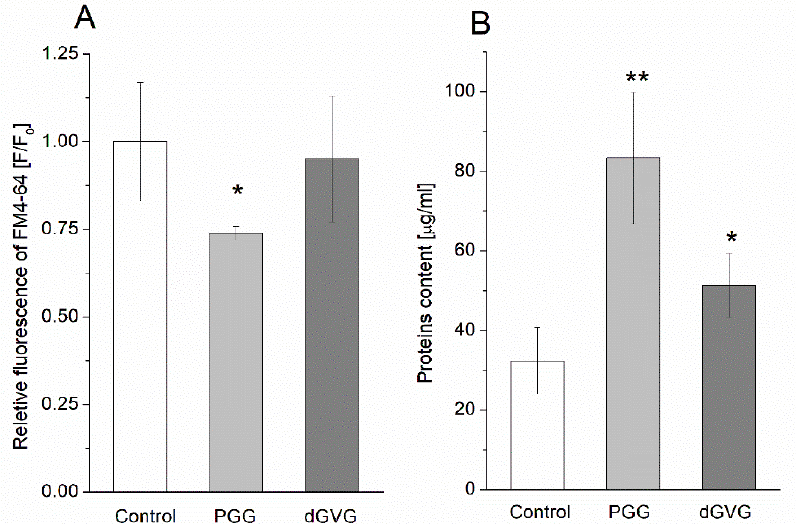
Figure 9. ( A ) Lipid and ( B ) protein quantifications of purified S. aureus membrane vesicles released by bacteria cultivated without tannins, with PGG 40 µ M, and with dGVG 40 µ M. Lipid quantification was determined by fluorescent FM4-64 dye and is presented as the ratio of the fluorescence in the sample with tannins (F) to the fluorescence of the control sample (Fo). Protein concentration was measured by Lowry Assay. Data are represented as mean ± SD of three biological replicates. * p < 0.05, ** p < 0.01.